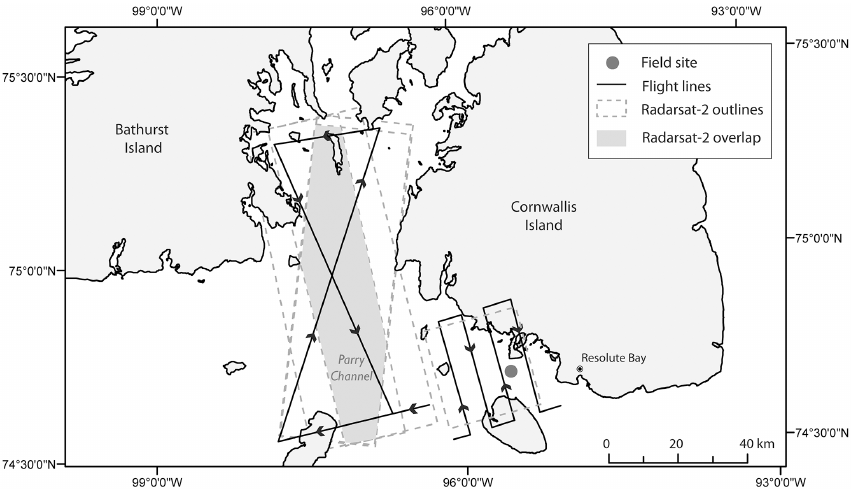
Figure 1. Map showing location of study area adjacent to the hamlet of Resolute Bay, NU, in the central Canadian Arctic Archipelago. Aerial photography flight lines over Parry and Field sites are shown along with outlines of 75km × 25km (Parry) and 25km × 25km (Field) Radarsat-2 scenes. The shaded region over Parry denotes the overlapping portion of scenes acquired over the